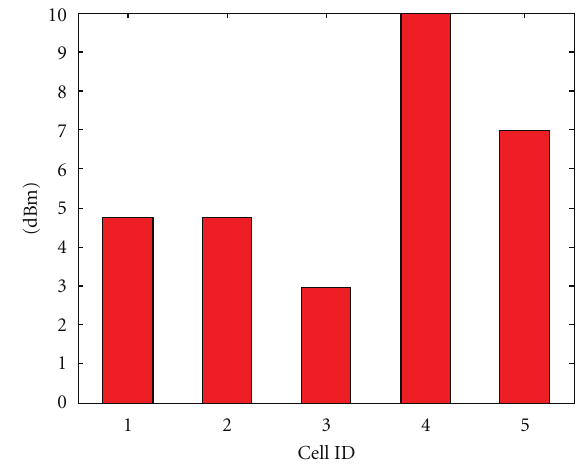
Figure 17: Optimized pilot power when all weights set to 1 (no. of FBSs = 9).